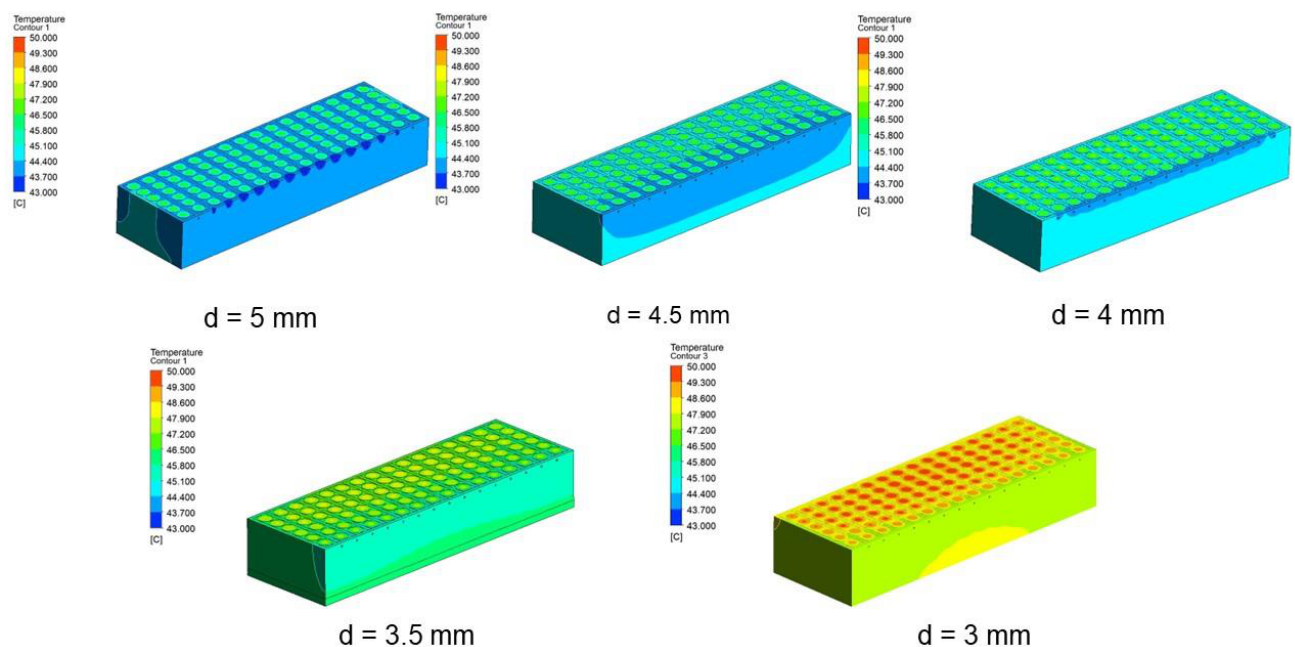
Figure 6. The temperature contour of the battery pack with different distances from the battery to the cold plate at 1800 s.